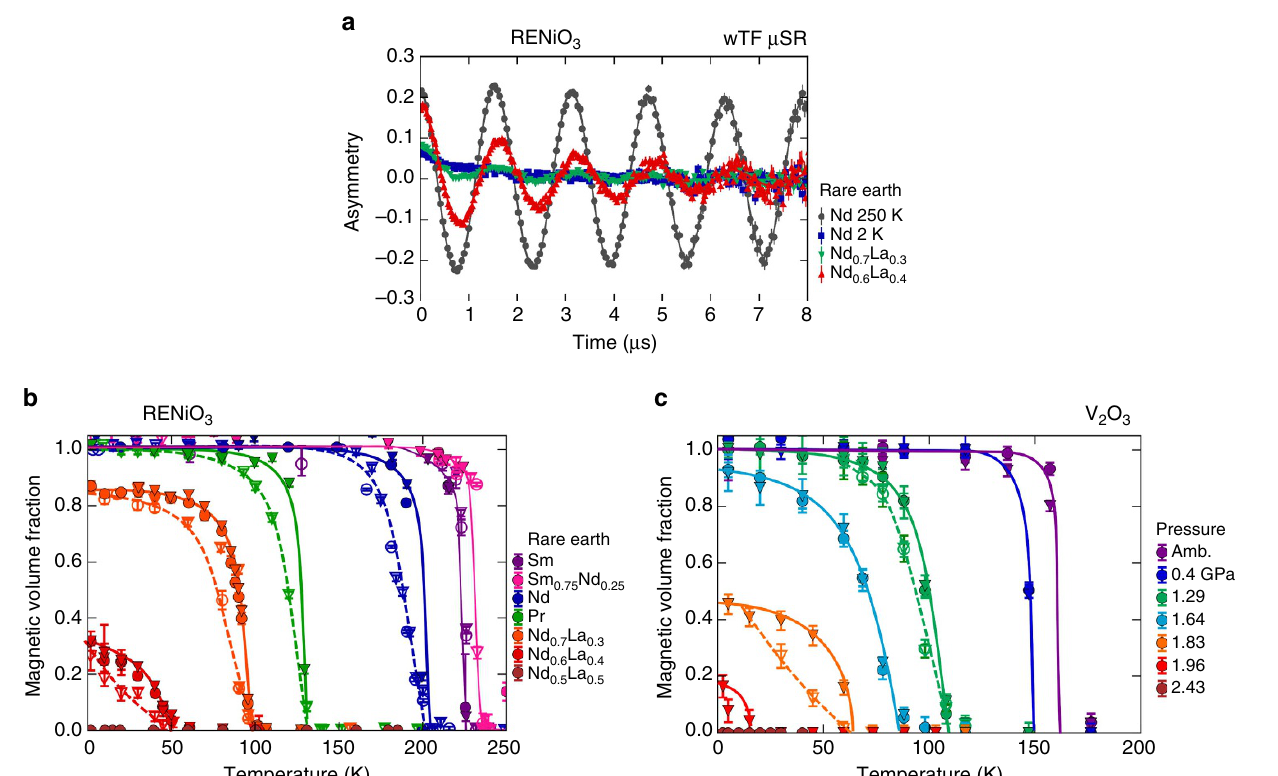
Figure 3 | Weak transverse field (wTF) muon spin rotation ( l SR) experiments and magnetic volume fraction of RENiO 3 and V 2 O 3 . ( a ) wTF time spectra for three compounds of RENiO 3 near the quantum phase transition (QPT) at 2K, with one spectrum measured at higher temperature (250K) shown for comparison. The coloured dots represent the data, the solid curves the fits described in the text. ( b ) Temperature dependence of the magnetic volume fraction in RENiO 3 derived from the fits. Circles (triangles) represent wTF (ZF) measurements, and filled (open) symbols represent warming (cooling) sequences. Solid and dashed curves are guides to the eye, with solid corresponding to cooling and dashed to warming. The compounds near the QPT have a significantly reduced ordered volume fraction at low temperature, indicating phase separation between magnetic and paramagnetic regions of the sample. Error bars were obtained by propagating the estimated standard deviations (ESDs) of the refined asymmetry values produced from the least- squares minimization. ( c ) Magnetic volume fraction of V 2 O 3 under different hydrostatic pressures. The symbols are the same as in b . As with RENiO 3 , the ordered volume fraction is strongly reduced near the